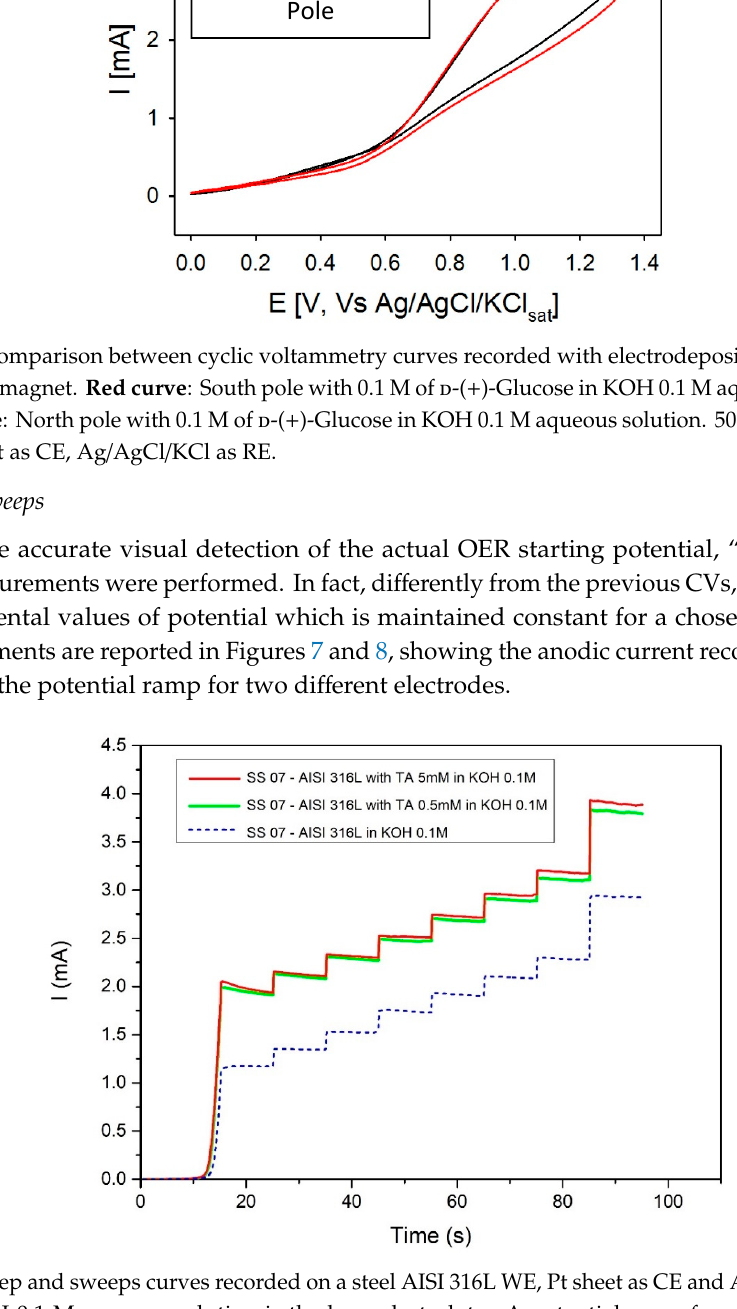
Figure 7. Step and sweeps curves recorded on a steel AISI 316L WE, Pt sheet as CE and Ag/AgCl/KCl